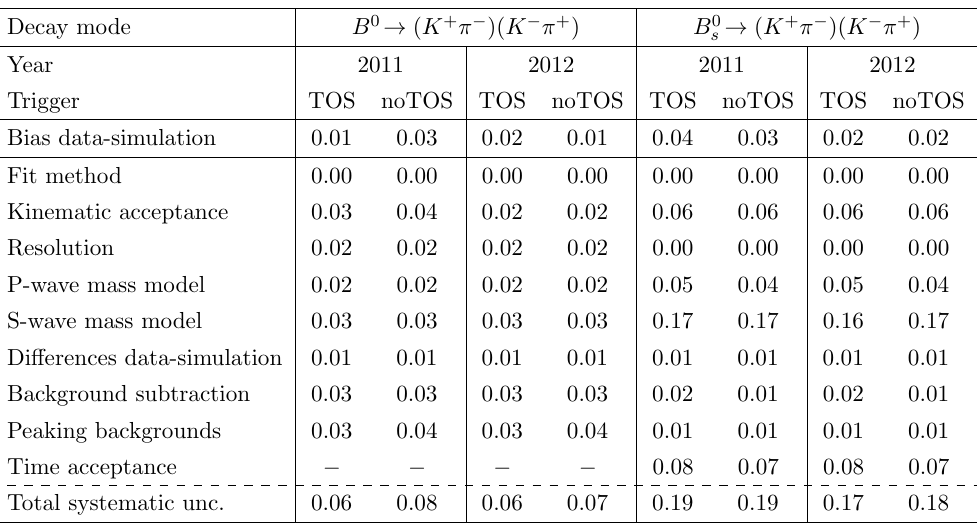
Table 8 . Systematic uncertainties in the factor (cid:20) de(cid:12)ned in eq. (8.2) split in categories. The bias originated in di(cid:11)erences between data and simulation is corrected for in the (cid:20) results shown in table